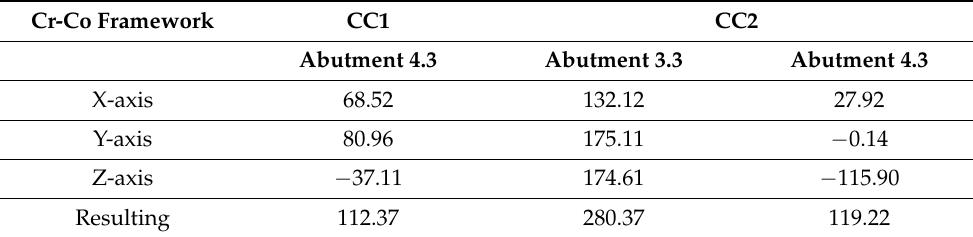
Table 3. Results of FEA evaluation for the Co-Cr framework in CC1 and CC2 R = resulting (reaction) force; X,Y,Z = (reaction) components of the resulting force; unit of measurement = reaction force (N). Cr-Co Framework CC1 CC2 Abutment 4.3 Abutment 3.3 Abutment 4.3 X-axis 68.52 132.12 27.92 Y-axis 80.96 175.11 − 0.14 Z-axis − 37.11 174.61 − 115.90 Resulting 112.37 280.37